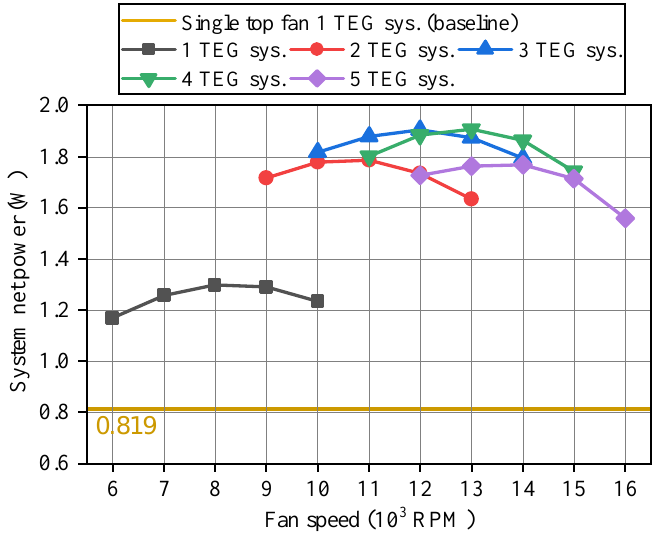
Figure 10. System net power of the various SMF systems at different fan speeds compared with the most efficient system net power of the TMF system with one TEG.